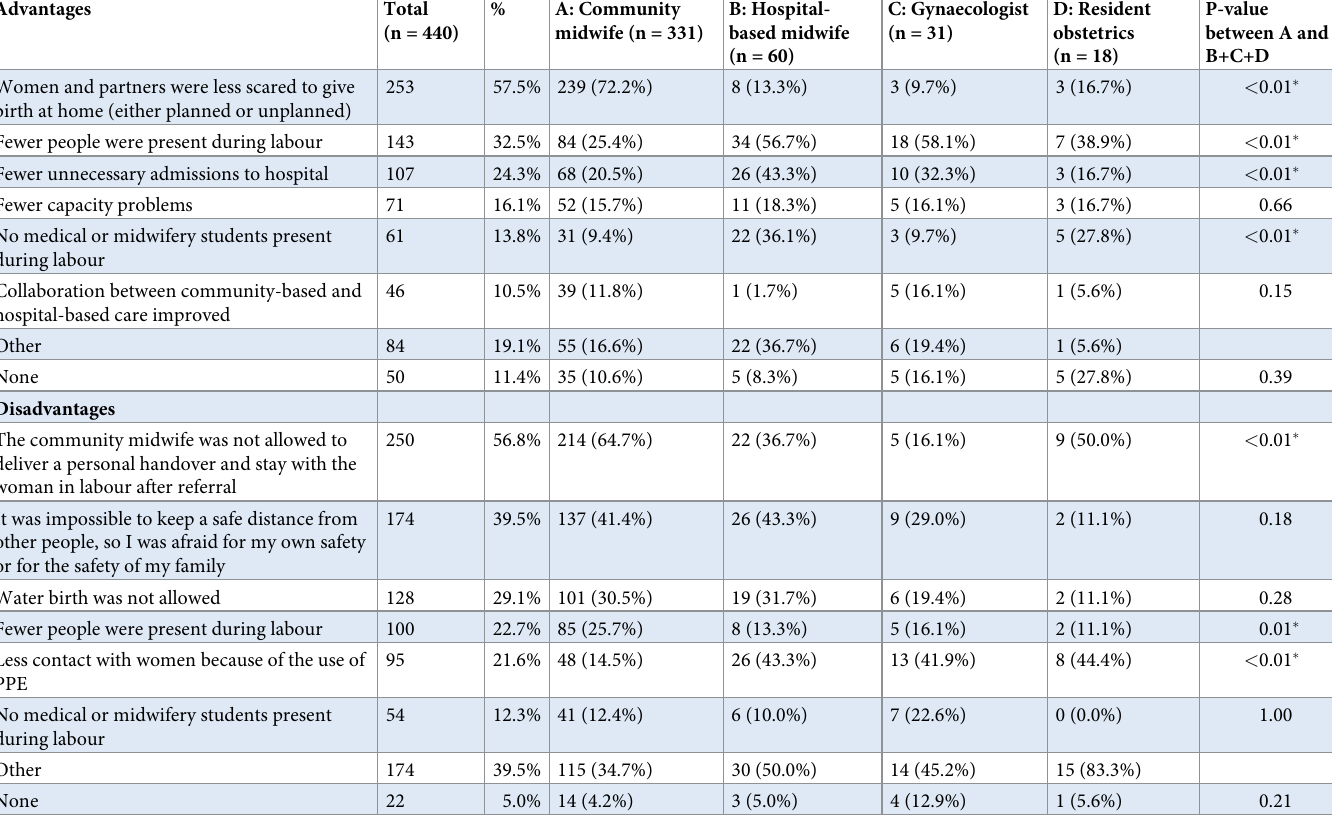
Table 3. Advantages and disadvantages of the changes in intrapartum care as experienced by maternity care